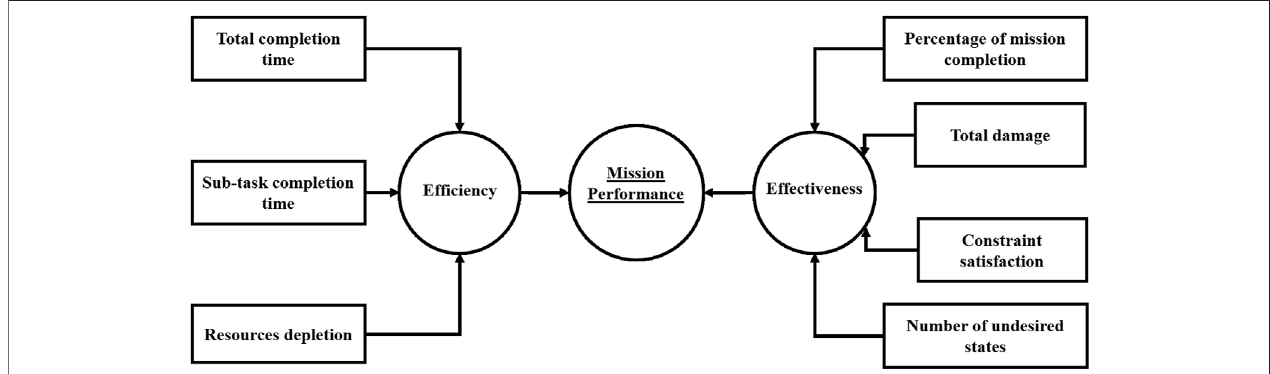
FIGURE 2 | Examples of useful indicators for mission